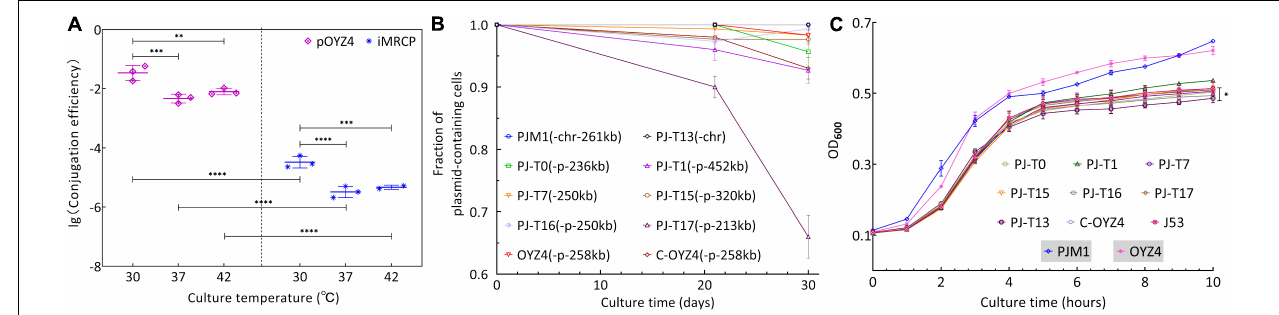
FIGURE 5 | (A) Comparison of transfer efficiencies of MRCP and IncHI2 plasmid pOYZ4 into E. coli J53. Transfer efficiency (mean ± standard deviation) is calculated based on colony counts of the transconjugant and recipient cells in triplicate. (B) Stability of MRCP in PJM1 and its progeny in E. coli J53 for 30 days. (C) Growth curves of representative J53-transconjugants, recipient strain E. coli J53, and donor strain PJM1. Salmonella OYZ4 serves here as a contrast strain for PJM1. Considering the interspecific difference, comparisons were performed between the J53-transconjugant and E. coli J53, and between PJM1 and OYZ4, respectively. All experiments were repeated independently in triplicate. The error bars denote the standard deviations ( n = 3). Two-way analysis of variance (ANOVA) with Tukey’s multiple comparison was used to evaluate statistical significance. Significantly different at ∗ P ≤ 0.05; ∗∗ P ≤ 0.01; ∗∗∗ P ≤ 0.001; ∗∗∗∗ P ≤